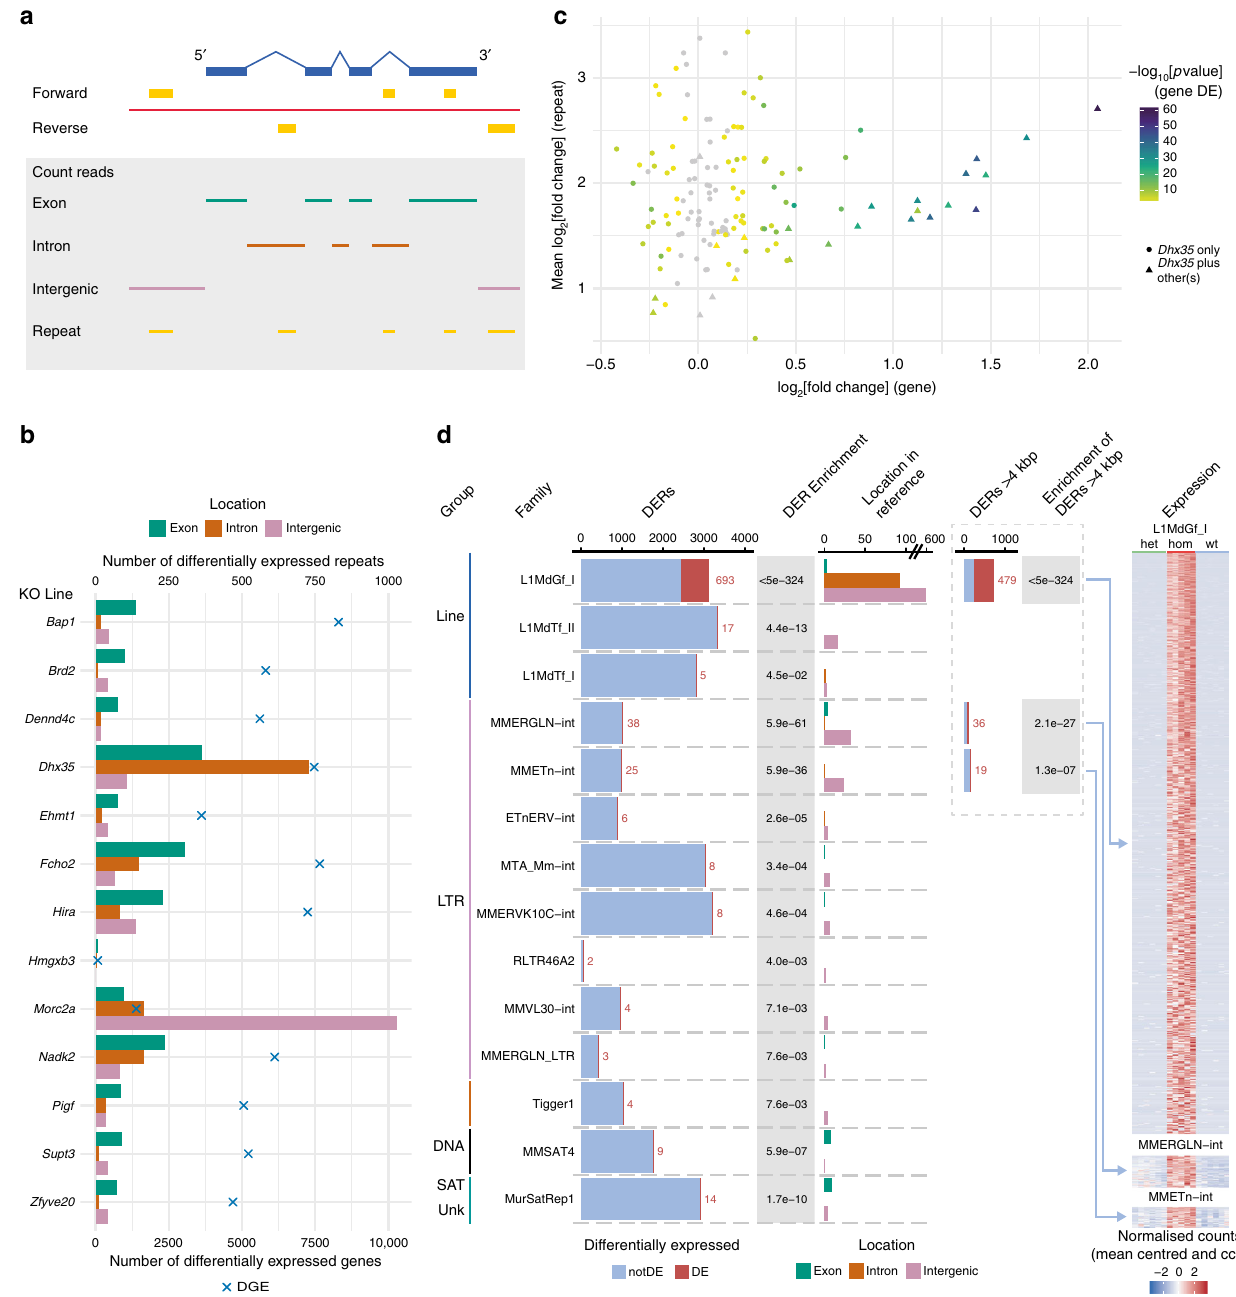
Fig. 7 Investigation of repeat deregulation. a Schematic representing a region of the genome (red line), a gene on the forward strand (exons are blue boxes and introns are blue lines) and strand-speci fi c repeats (yellow boxes). The area within the grey box shows the genomic stretch where strand-speci fi c reads were considered within exons (green), within introns (brown), intergenic (purple) or within annotated repeats (yellow). b Differential repeat and gene expression for 13 mutant lines ( Hmgxb3 acts as a negative control). For each mutant line the number of differentially expressed repeat instances (DERs) is shown on the top x -axis split by genomic location (bars). The number of genes differentially expressed (homozygotes versus siblings) for each mutant line are indicated by a cross and shown on the bottom x -axis. Dhx35 has a large number of DERs in intronic regions (brown bar), whereas for Morc2a they are mostly in intergenic regions (purple bar). c Fold change of repeats and genes in Dhx35 mutant line. Genes enriched for the number of intronic DERs, if greater than 1 instance, compared to all introns for each gene are shown by circles (unique to Dhx35 ) or triangles (found in Dhx35 and at least one other mutant), ENSMUSG00000107482 has no exon counts and was excluded from the plot. The colour shows the adjusted p value ( − log 10 scaled) from DESeq2 for the gene with grey as not signi fi cant. The log 2 [fold change] for the gene is on the x -axis with the mean fold change of intronic DERs on the y - axis. d Repeat instance expression in the Morc2a mutant line. Only repeat families enriched for individual DERs against total instances in the genome are shown. Bar shows total repeat instances with DERs in red. Bars in the Location in Reference column display the number of DERs by genomic location relative to gene annotation. Dashed box shows subset of repeat instances ≥ 4 kb. Mean centred and scaled heatmaps in the Expression column are of expression levels of DERs (L1MdGf_I, MMERGLN-int and MMETn-int families) across heterozygous (het), homozygous (hom) and wild-type (wt) Morc2a embryos. Source data are provided as a Source Data fi